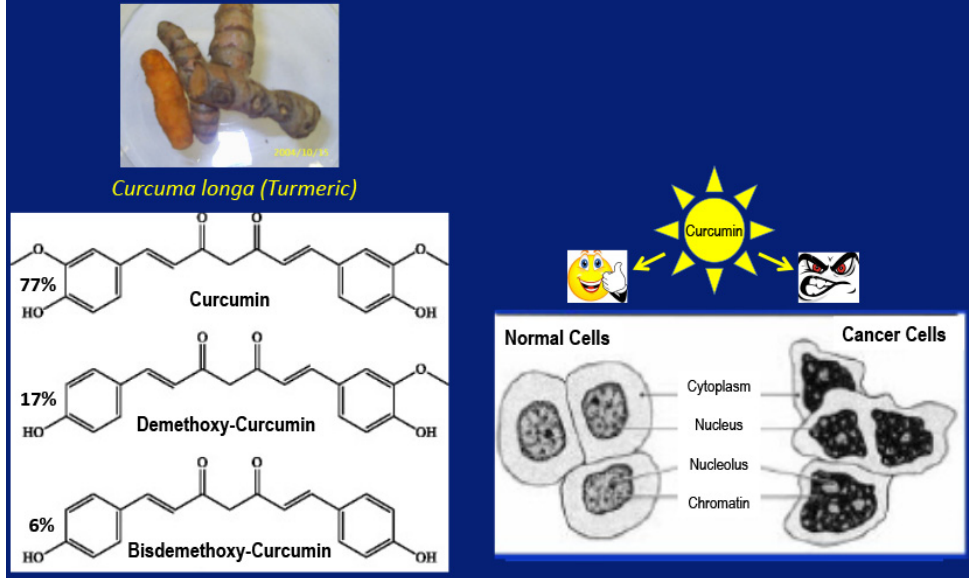
Figure 1. Curcumin occurs in the rhizome of the plant curcuma longa as a mixture of three closely related polyphenols and displays differential activity toward cancer cells and normal